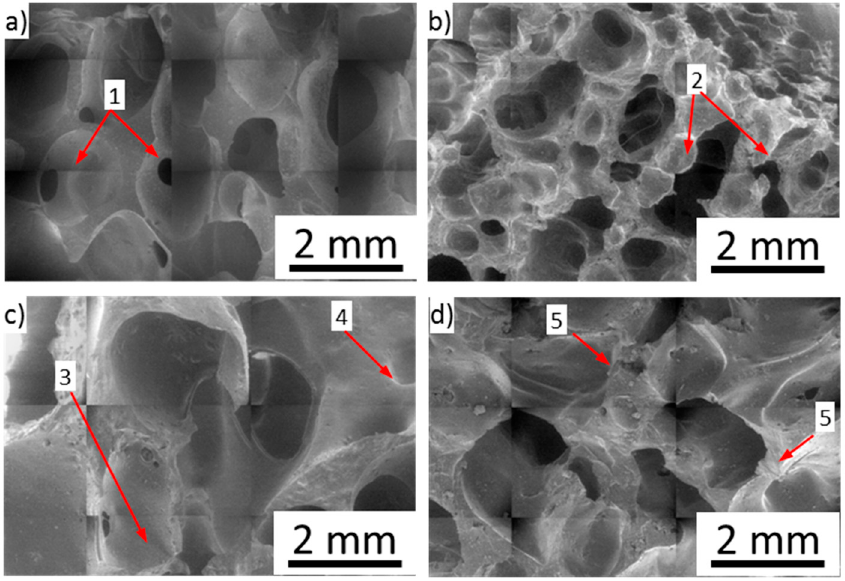
Figure 12. SEM images of ( a ) F-AR, ( b ) F-CNT0, ( c ) F-CNT22, and ( d ) F-CNT36 foams.